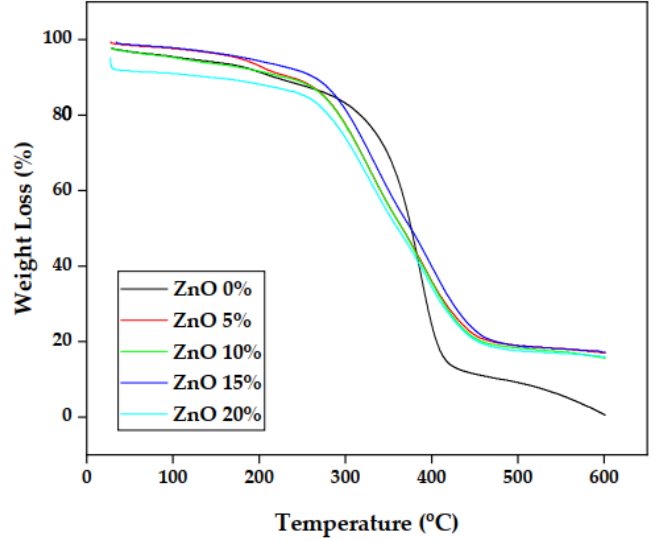
Figure 10. Graph of thermogravimetry analysis (TGA) at each variation of ZnO.